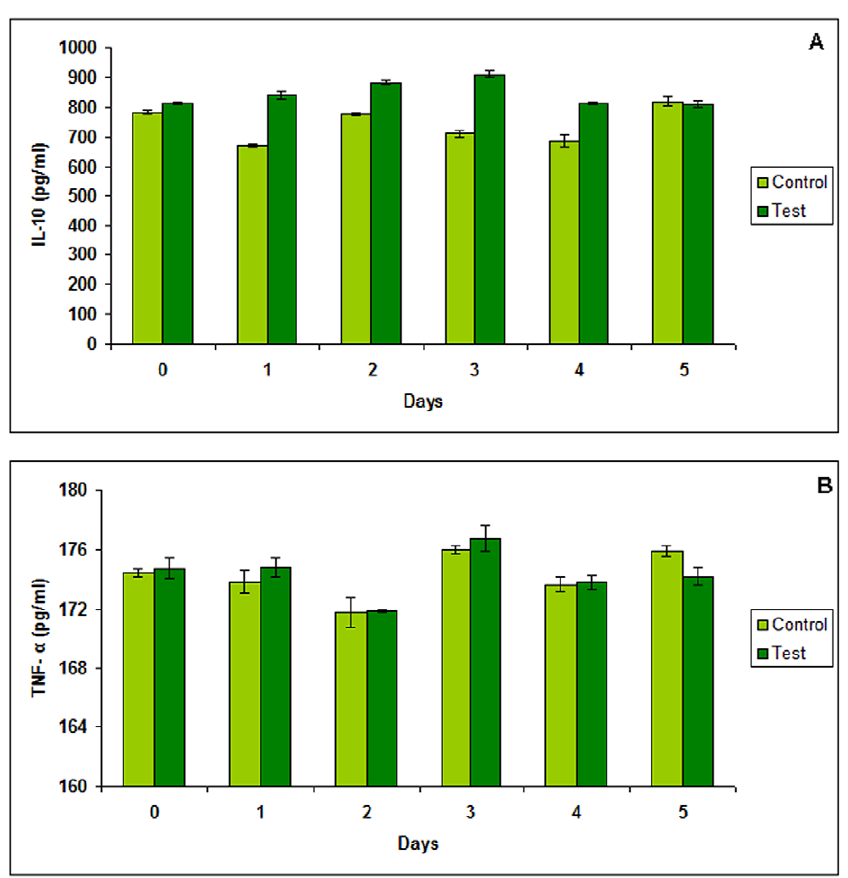
Figure 4. Estimation of IL-10 and TNF- a levels in mouse vaginal homogenates. Determination of (A) IL-10 and (B) TNF- a levels in mouse vaginal homogenates collected at 24 h intervals from days 0, 1, 2, 3, 4 and 5, during vaginal administrations of 10 8 cfu of S. aureus. Data represents mean of three observations. Results are expressed as mean 6 S.D.